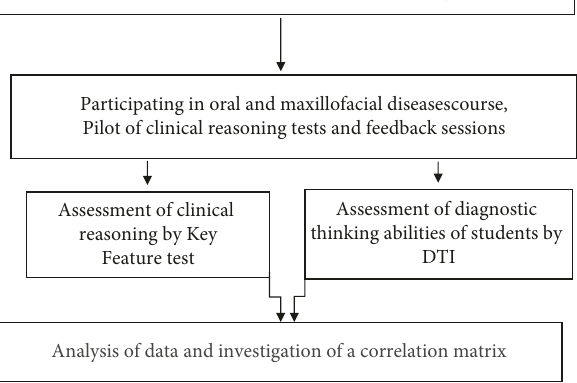
Figure 2: Flow chart of the study